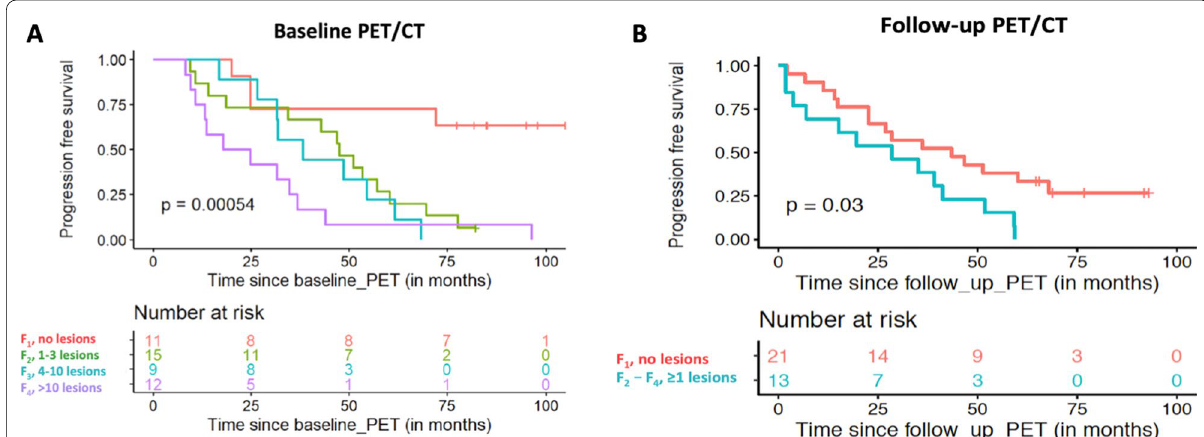
Fig. 4 Kaplan–Meier estimates of PFS according to the number of focal, hypermetabolic lesions (Fx) at baseline ( A ) and follow‑up PET/CT ( B ). At baseline, the patients are divided according to the four groups of the Fx score ( A ), while at follow‑up, they are dichotomized in those having no lesions (F1), and those presenting with at least one lesion (F2–F4). The numbers of patients at risk in each group and for the respective time‑points are shown below the